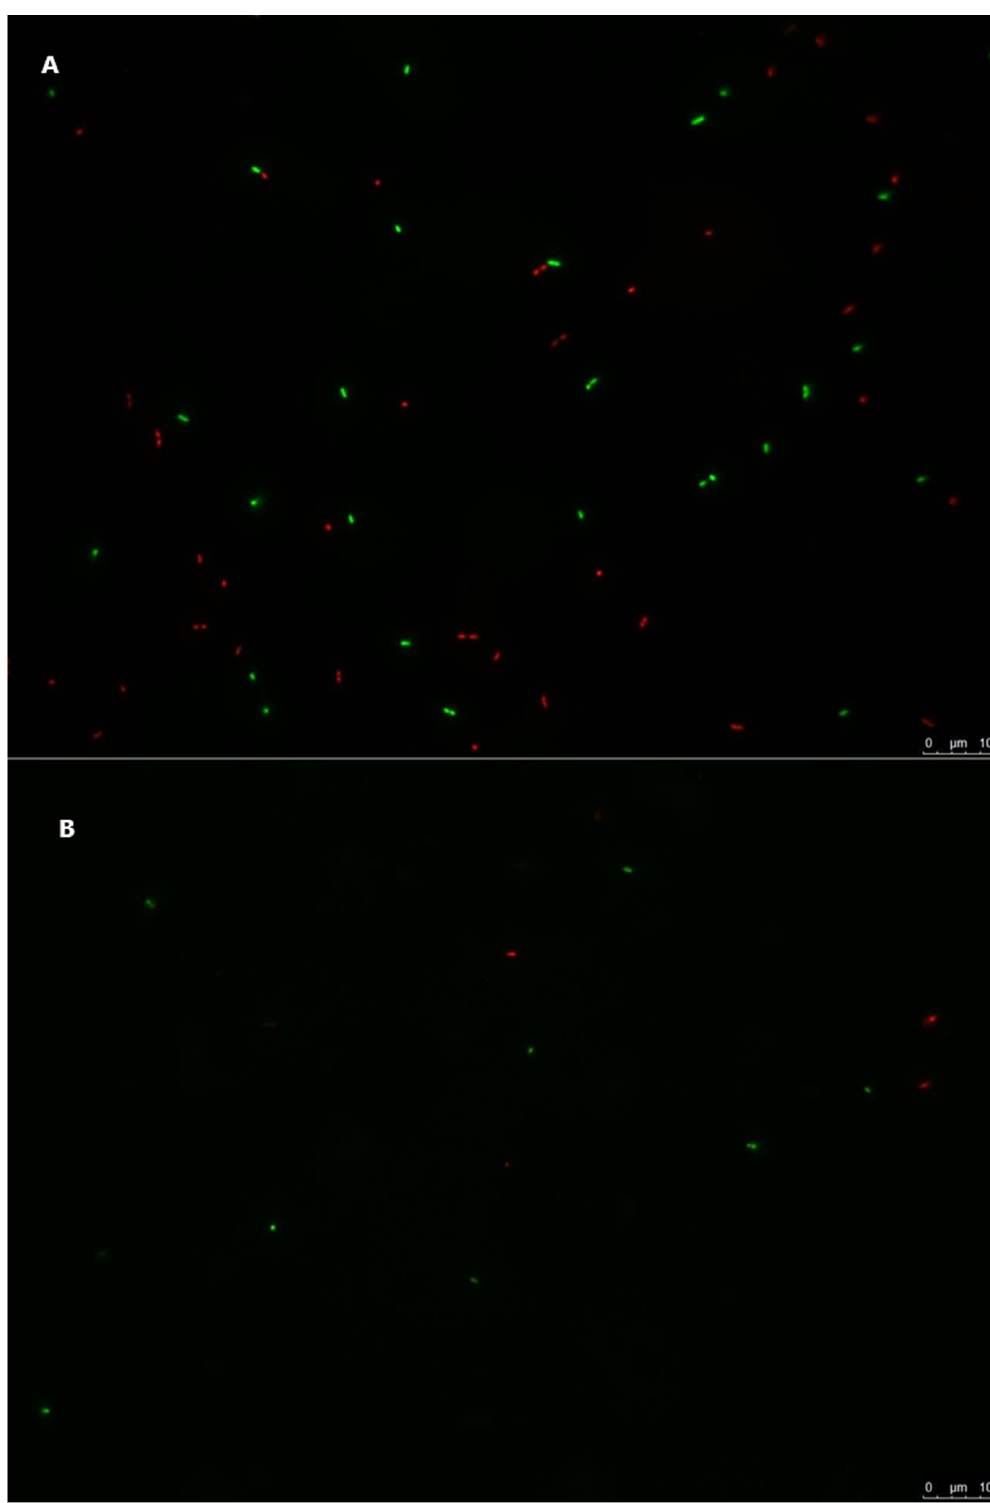
Figure 4. L. innocua ATCC 51472 StrepR inoculated in stored irrigation water microcosms, labelled with a live/dead staining protocol. Green-labelled cells are live, and red-labelled cells are injured or dead. The scale bar on each picture represents 10 µm. ( A ) L. innocua ATCC 51472 StrepR immediately after inoculation in stored irrigation water microcosms. ( B ) L. innocua ATCC 51472 StrepR 35 days after inoculation in stored irrigation water microcosms.